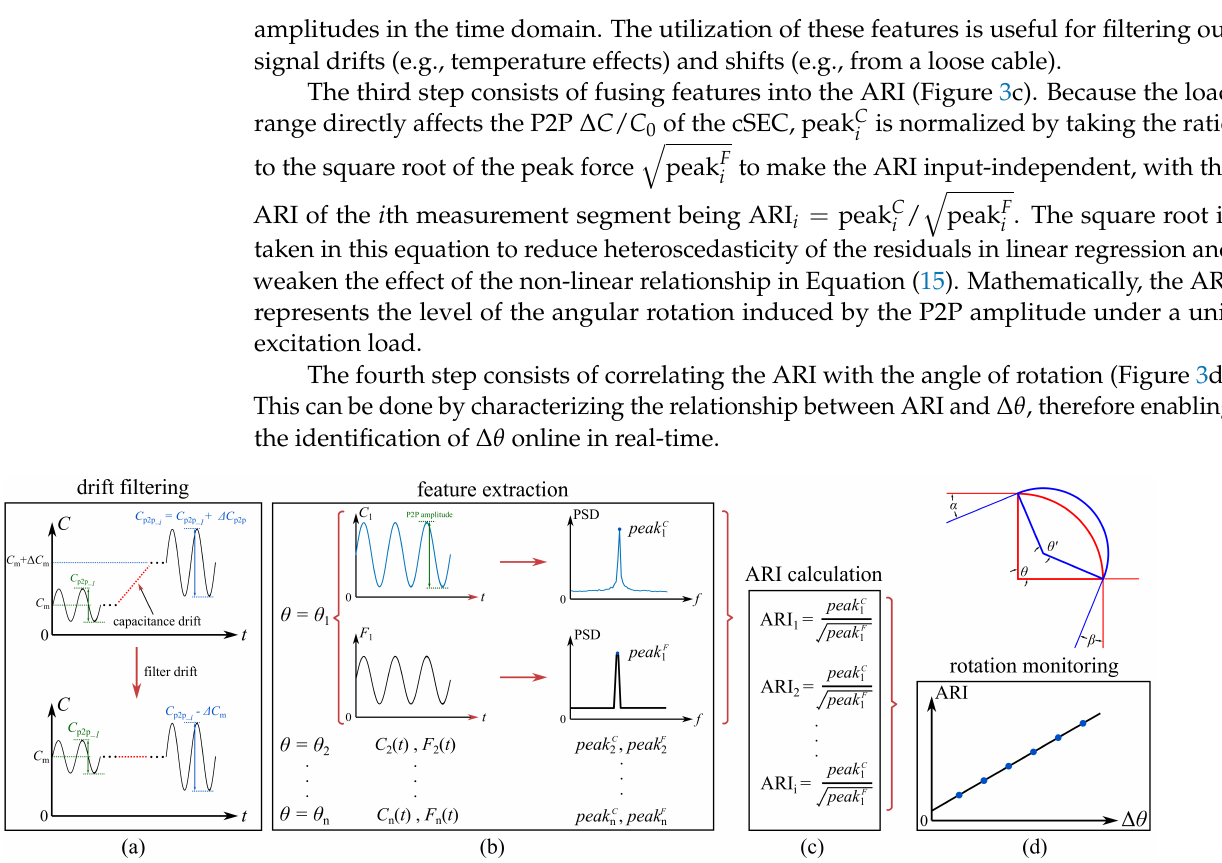
Figure 3. Four-step algorithm used on monitoring angle of rotation: ( a ) data acquisition and drift filtering; ( b ) feature extraction; ( c ) construction of ARI; ( d ) rotation